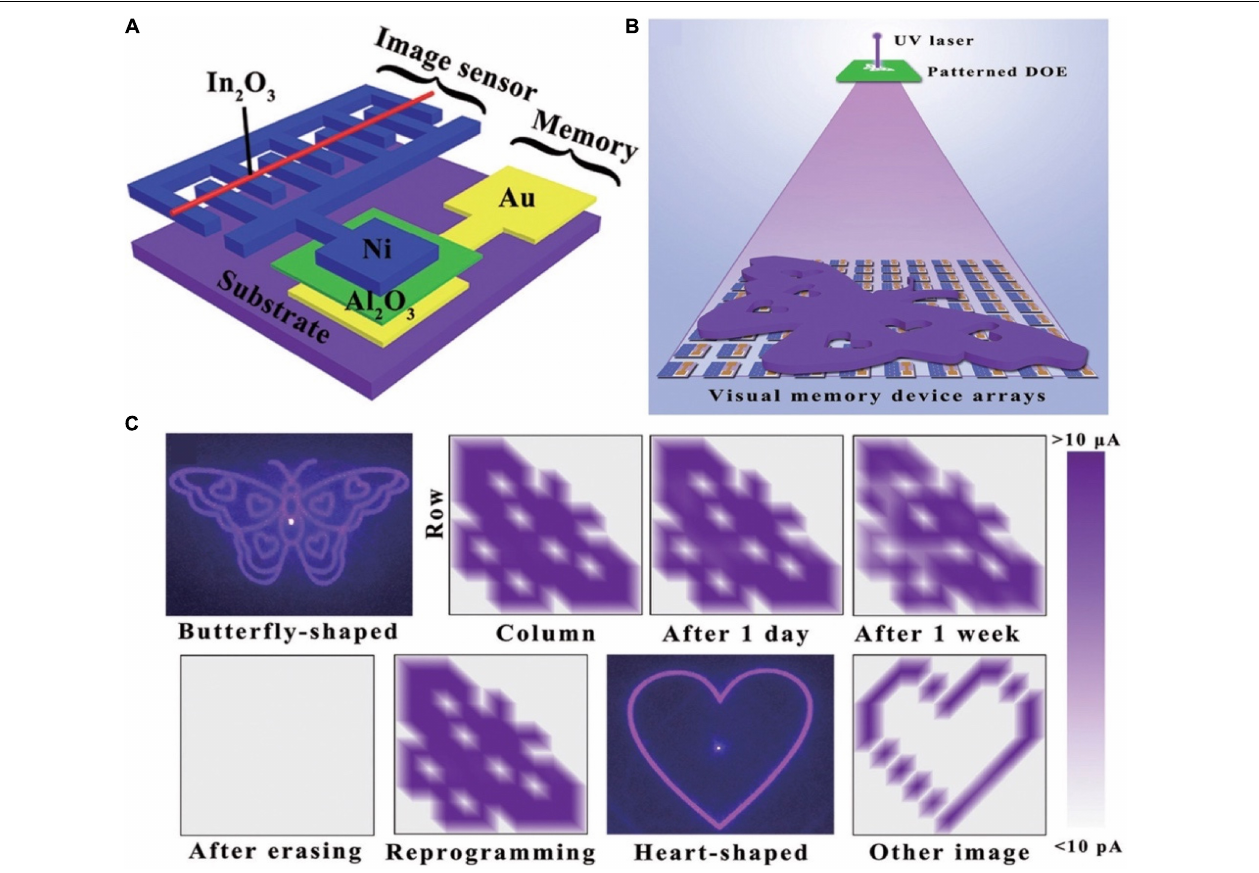
FIGURE 15 | (A) Schematic diagram of the bio-inspired visual memory unit integrated by resistive switching memory device and image sensor. (B) Schematic diagram of detecting and memorizing the light distribution which generated from patterned diffraction optical element (DOE). (C) Schematic of the resistance states between memory device and image sensor (adapted from Chen et al.,